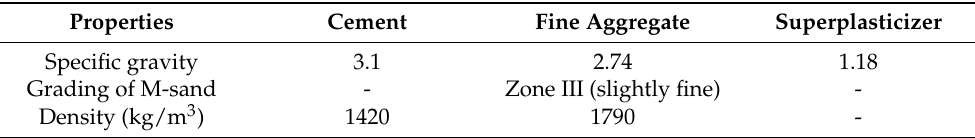
Table 1. Properties of Materials.